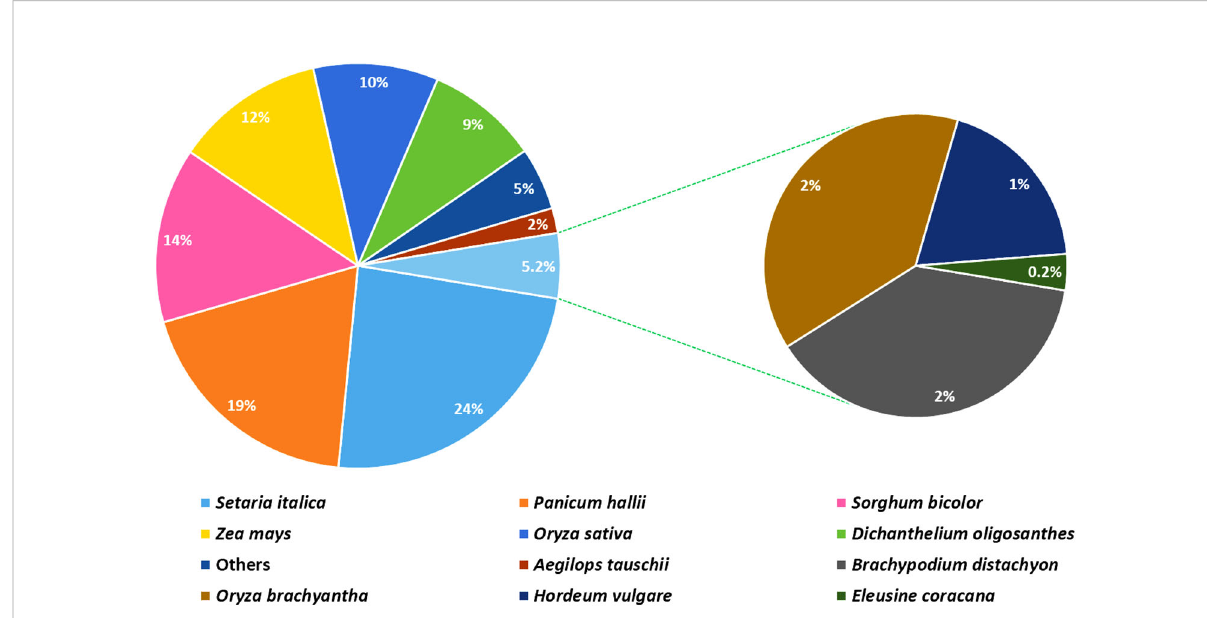
FIGURE 3 A pie chart depicting the distribution of plant species according to the top BLAST hits against the NCBI Non-redundant Protein database